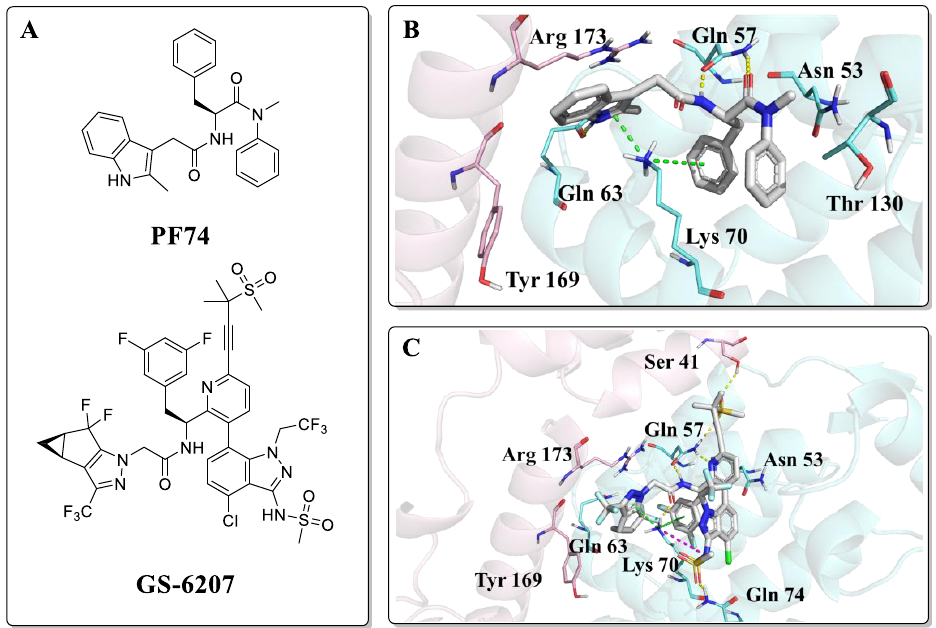
Figure 2. ( A ) Structures of PF74 and GS-6207 ; ( B ) Binding mode of PF74 , PDB ID: 5HGL; ( C ) Binding mode of GS-6207 , PDB ID: 6V2F. The two HIV-1 CA protomers are highlighted in cyan and pink. Cation- π interactions are shown in green dotted lines and hydrogen bonds in yellow dotted